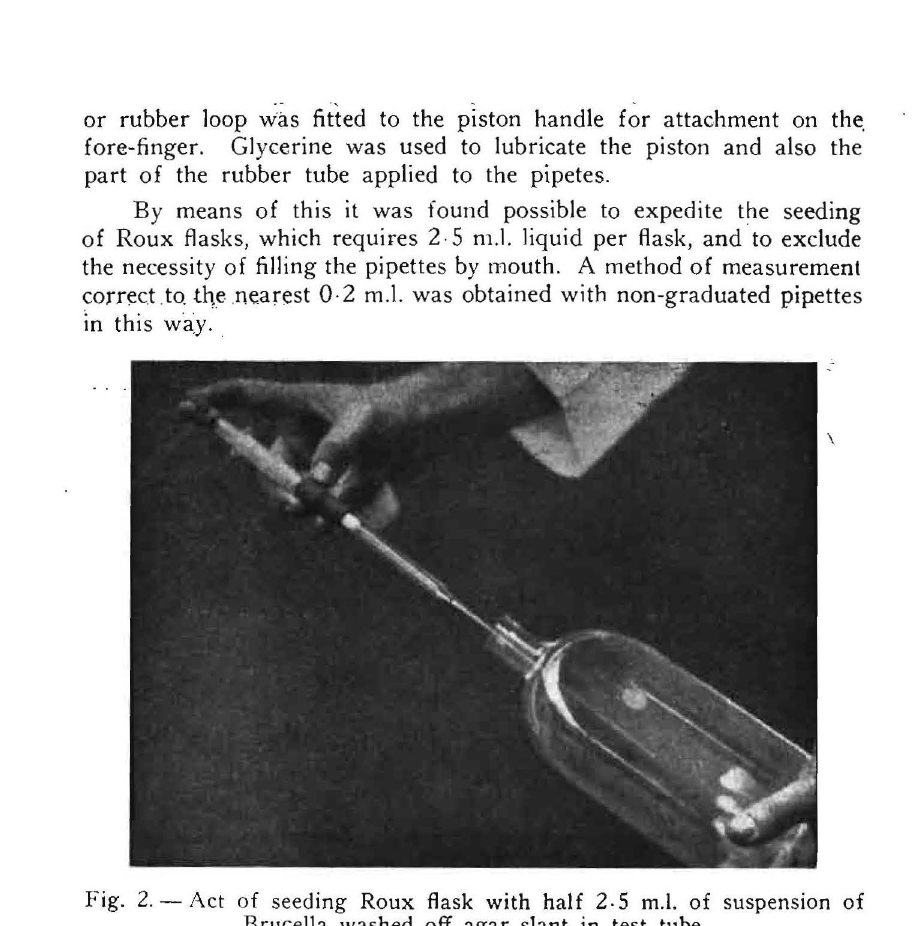
Fig. 2. - Act of seeding Roux flask with half 2·5 m.1. of suspension of Brucella washed off agar slant in test